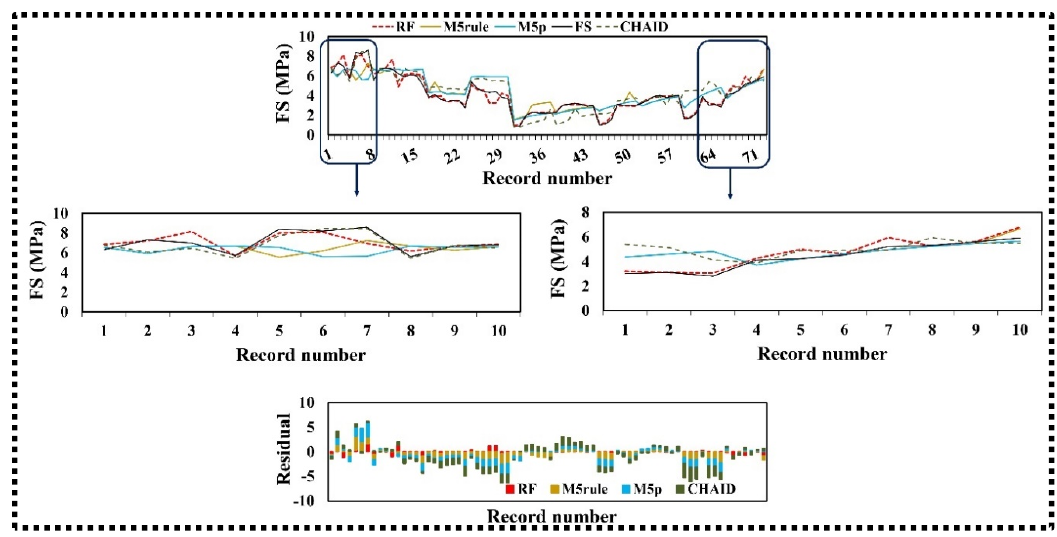
Figure 9. Time series and residual plots of the testing phase of the classification-based regression methods for FS estimation.